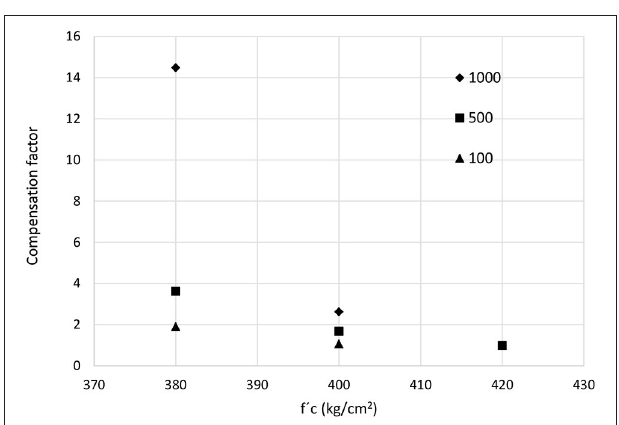
FIGURE 8 | Compensation factors for several actual values of f ′ c, several losses levels, H = 8m and nominal f ′ c = 200 Kg/cm 2 , Ciudad de